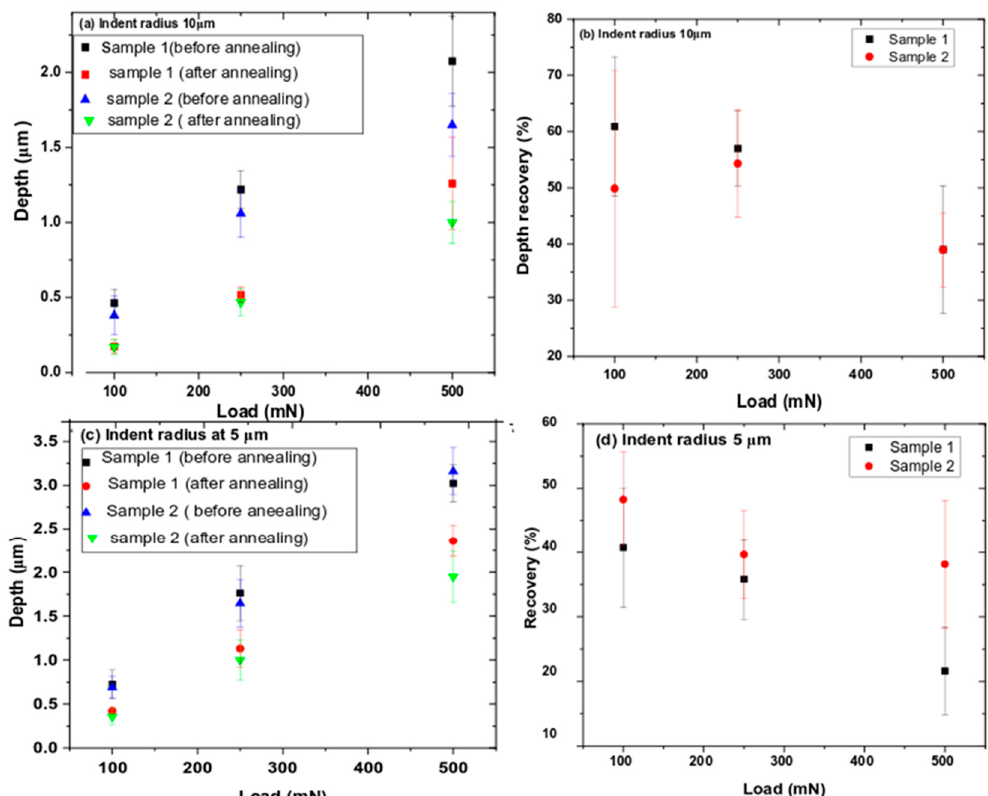
Figure 12. ( a – d ) Indentation residual depths and subsequent recoveries after annealing of samples 1 and 2.